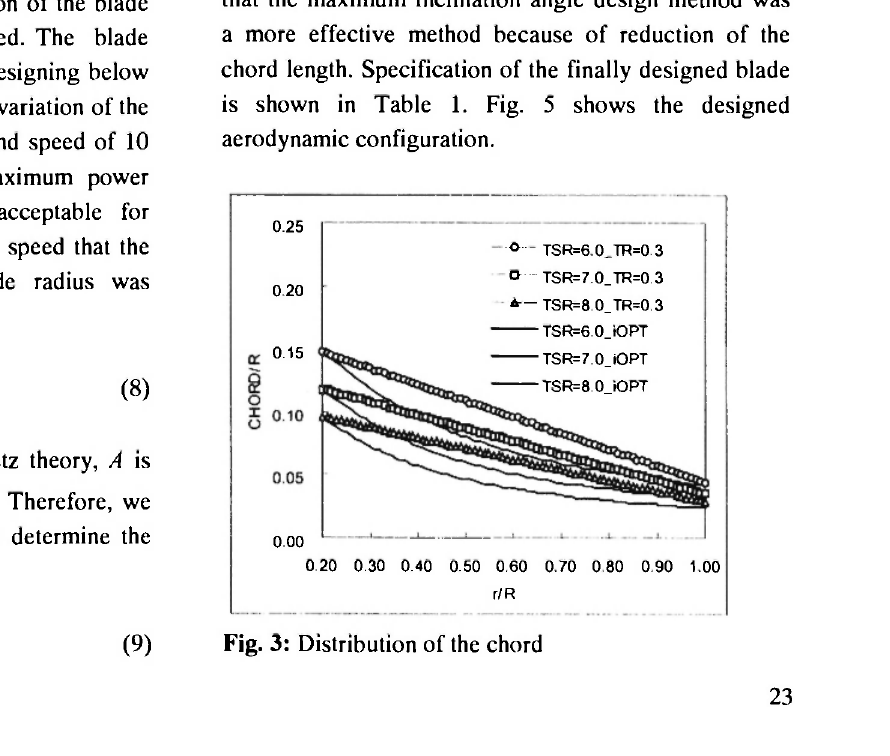
Fig. 3: Distribution of the